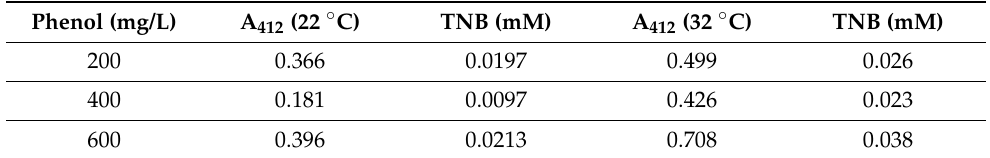
Table 1. PHA synthase activity assay. Absorption of the thiobenzoate anion resulting from the reaction of CoA and DTNB was measured at 412 nm and at 22 ◦ C or 32 ◦